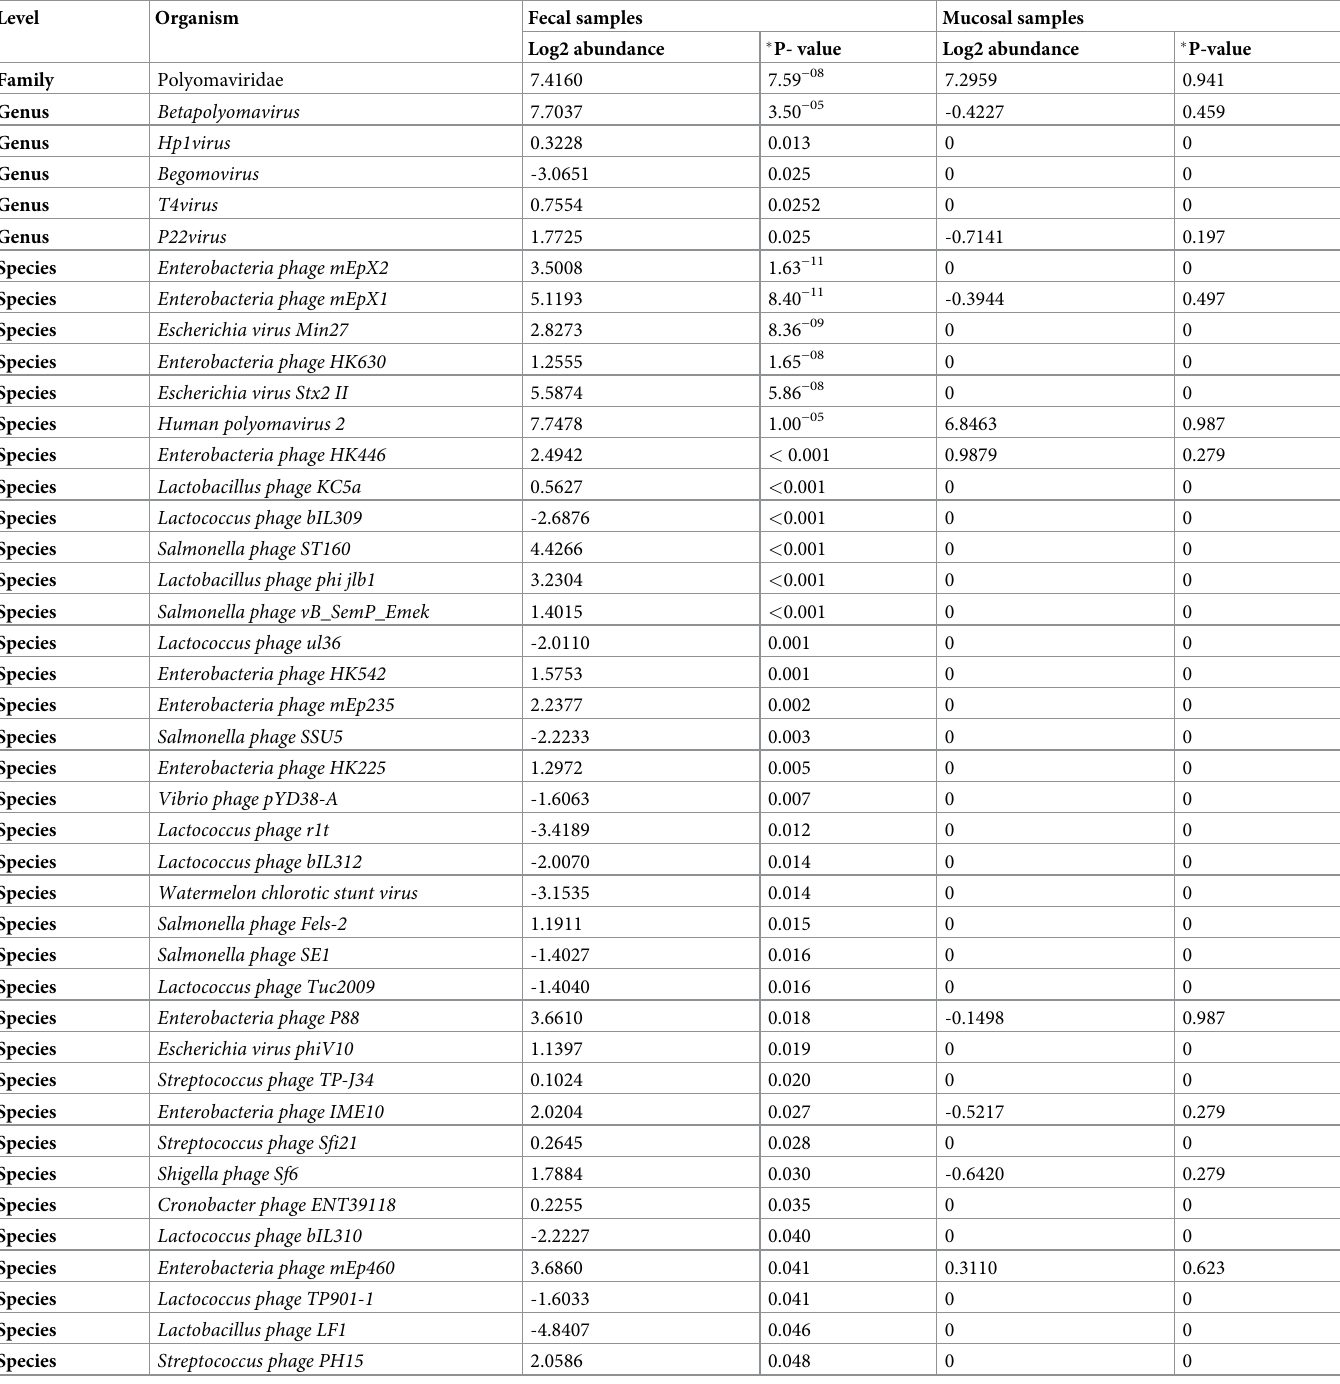
Table 2. Log2 abundance of viral taxa in fecal compared with mucosal